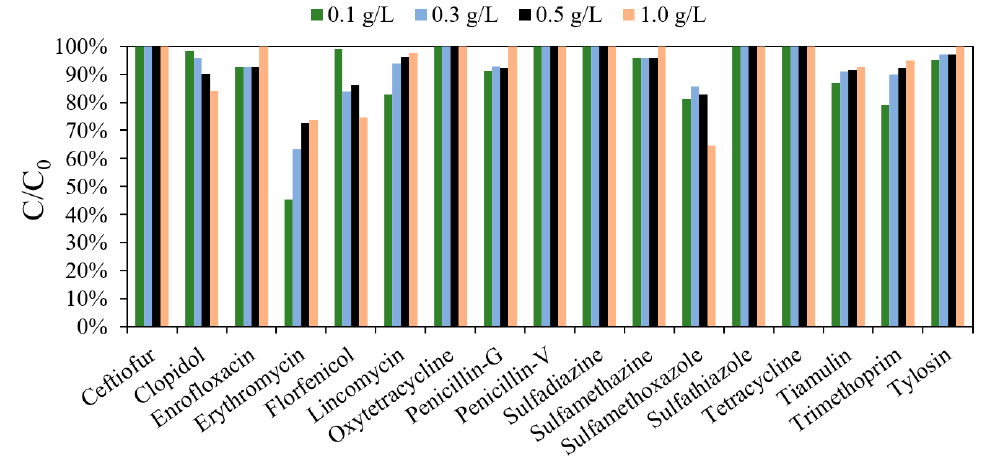
Figure 11. Degradation of target antibiotics using UV/TiO 2 photocatalysis for 60 min at different TiO 2 loadings.